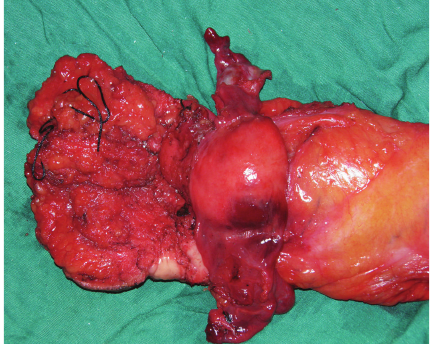
Figure 4: Growth in anorectal region.